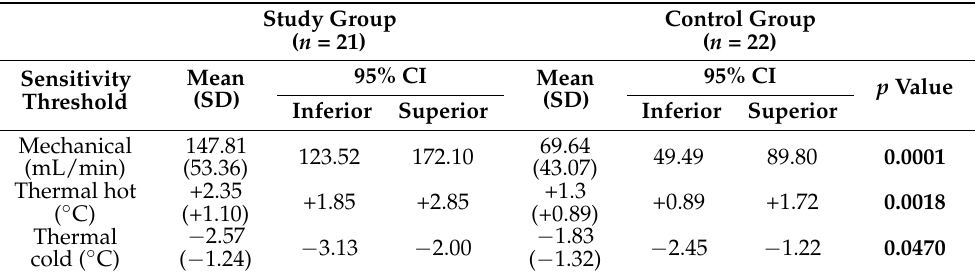
Table 2. Corneal sensitivity thresholds evaluated by non-contact esthesiometry in mercury- intoxicated patients (study group) and in healthy subjects (control